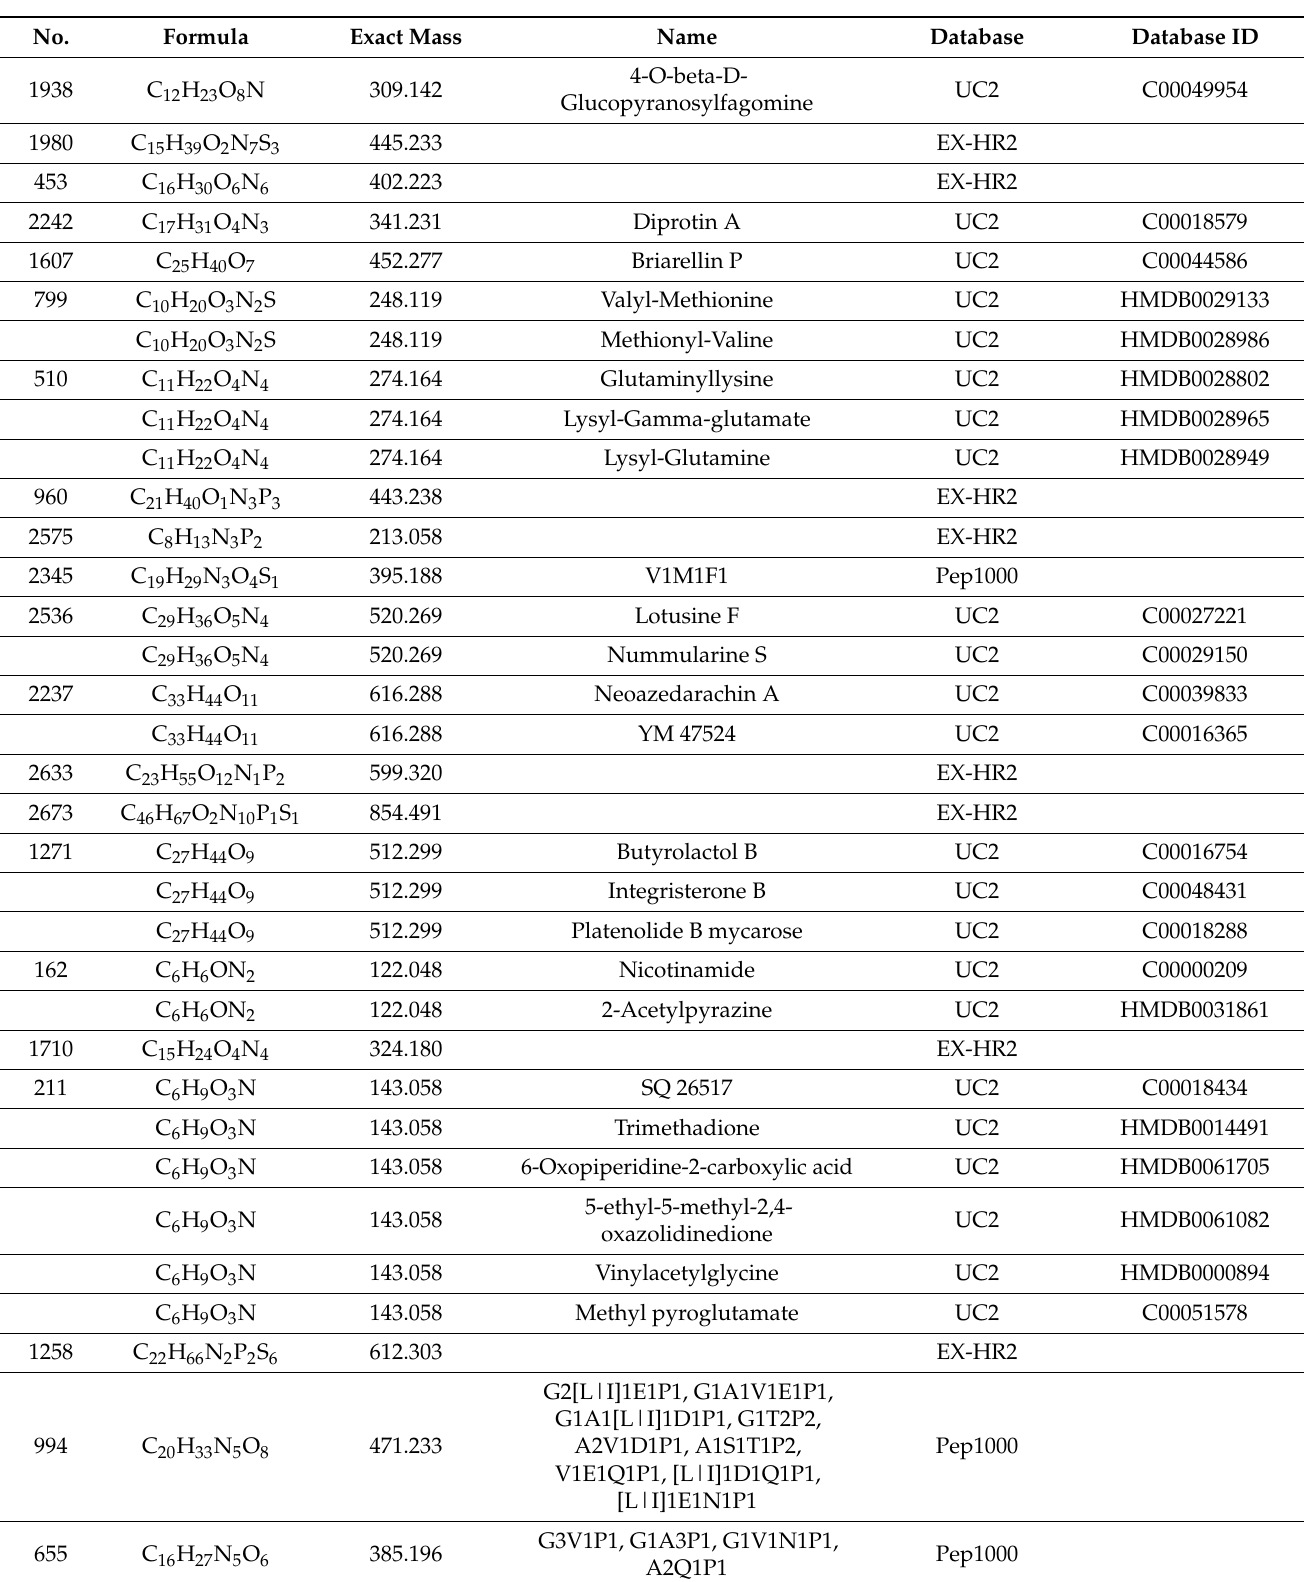
Table 2. The constituents in B. subtilis trpC2 broth detected by LC-MS/MS